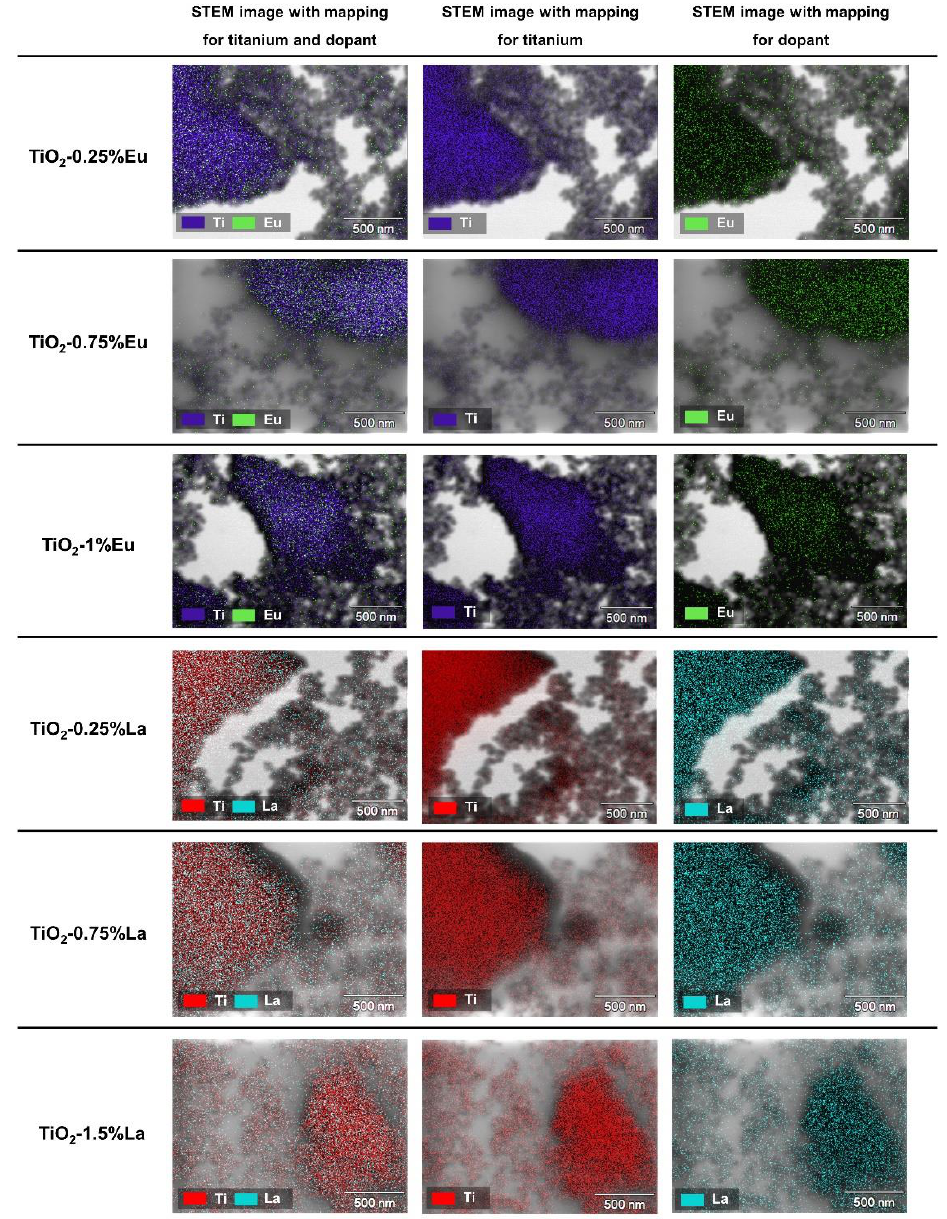
Figure 7. STEM images with mapping for titanium and europium/lanthanum for TiO 2 -Eu and TiO 2 -La systems.